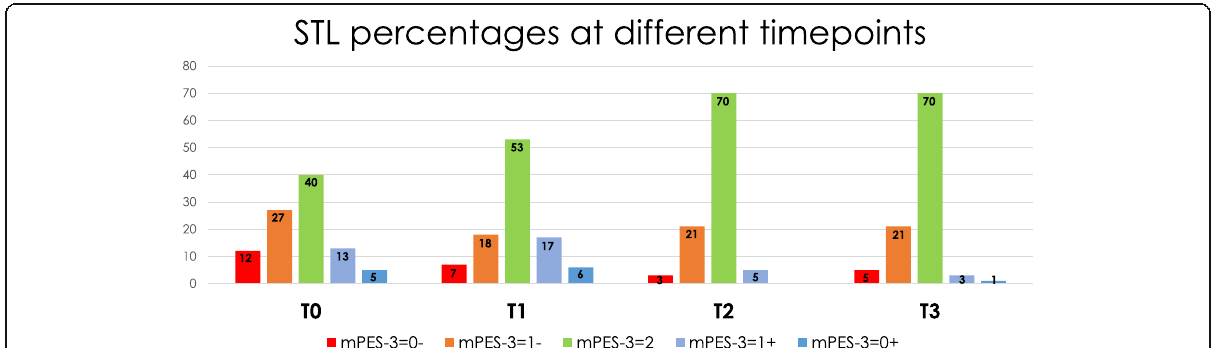
Fig. 2 Distribution of cases per STL-group (mPES-3 = 0 − , 1 − , 2, 1+, 0+) per time point in percentages. Red (mPES = 0 − ) and orange (mPES = 1 − )